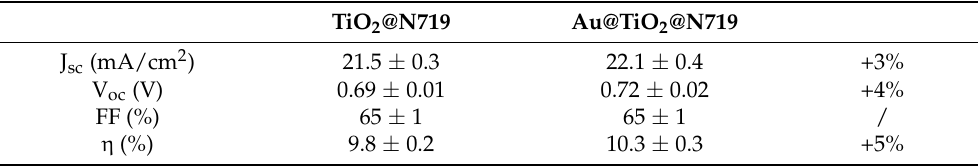
Table 3. Electrical parameter at 1 SUN, 100 mW/cm 2 (solar simulator) and 0.1 SUN, 10 mW/cm 2 (LED). Sample